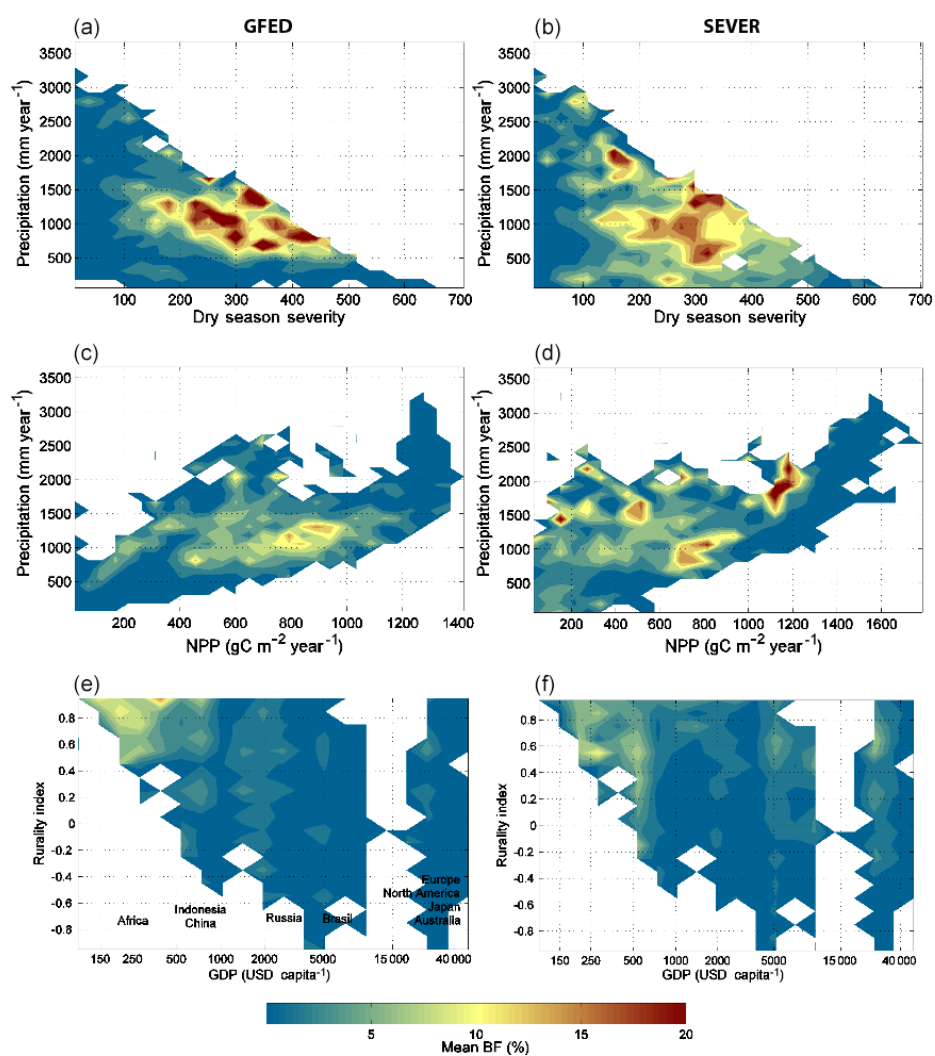
Figure 8. Mean annual burned fraction over 1997–2006 ( a, c, e : GFED; b, d, f : SEVER-FIRE) as a function of paired parameters. (a, b) An- nual precipitation and dry season severity; (c, d) precipitation and NPP; (e, f) rurality indicator and GDP.